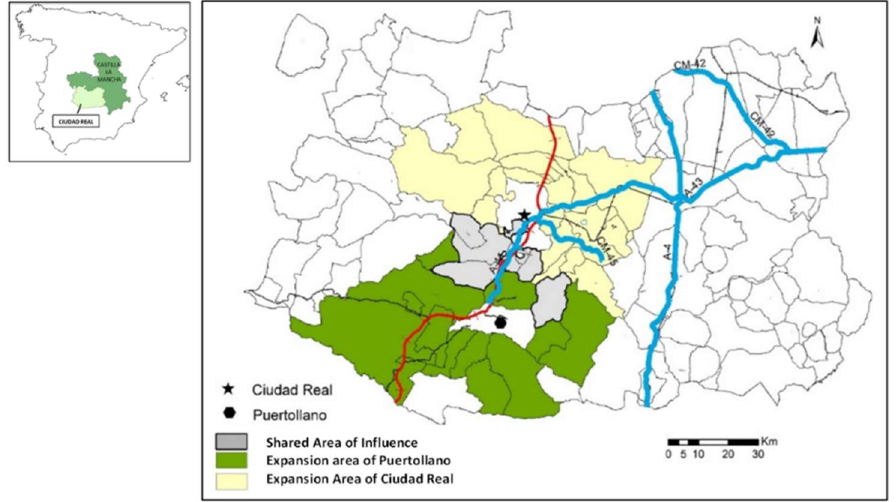
Figure 2. The Areas of Expansion of Ciudad Real and Puertollano, Source: [18] (p. 205).